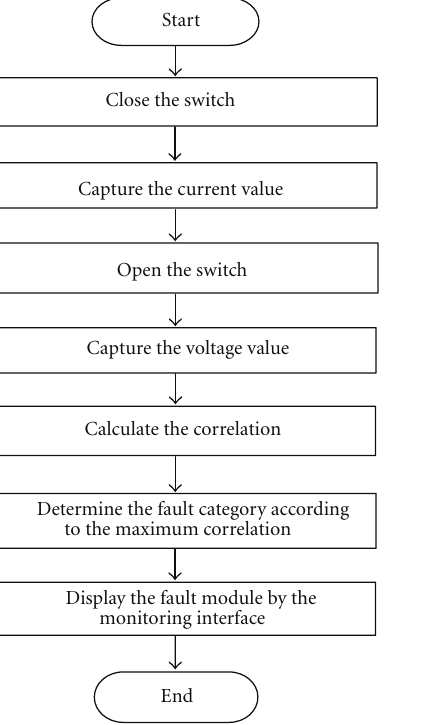
Figure 9: The flowchart of the second stage fault diagnosis.